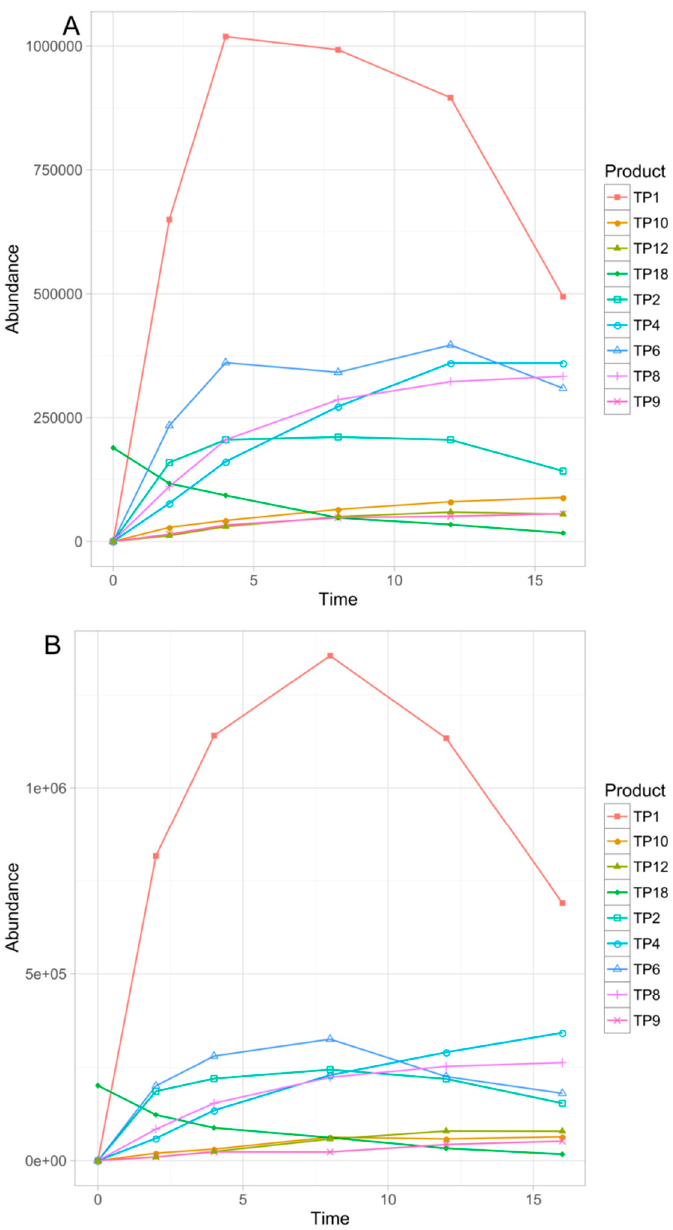
Figure 5. Evolution profiles of the TPs formed in TiO 2 –FeOOH ( A ) and TiO 2 –Fe 2 O 3 ( B ) photocatalysis.